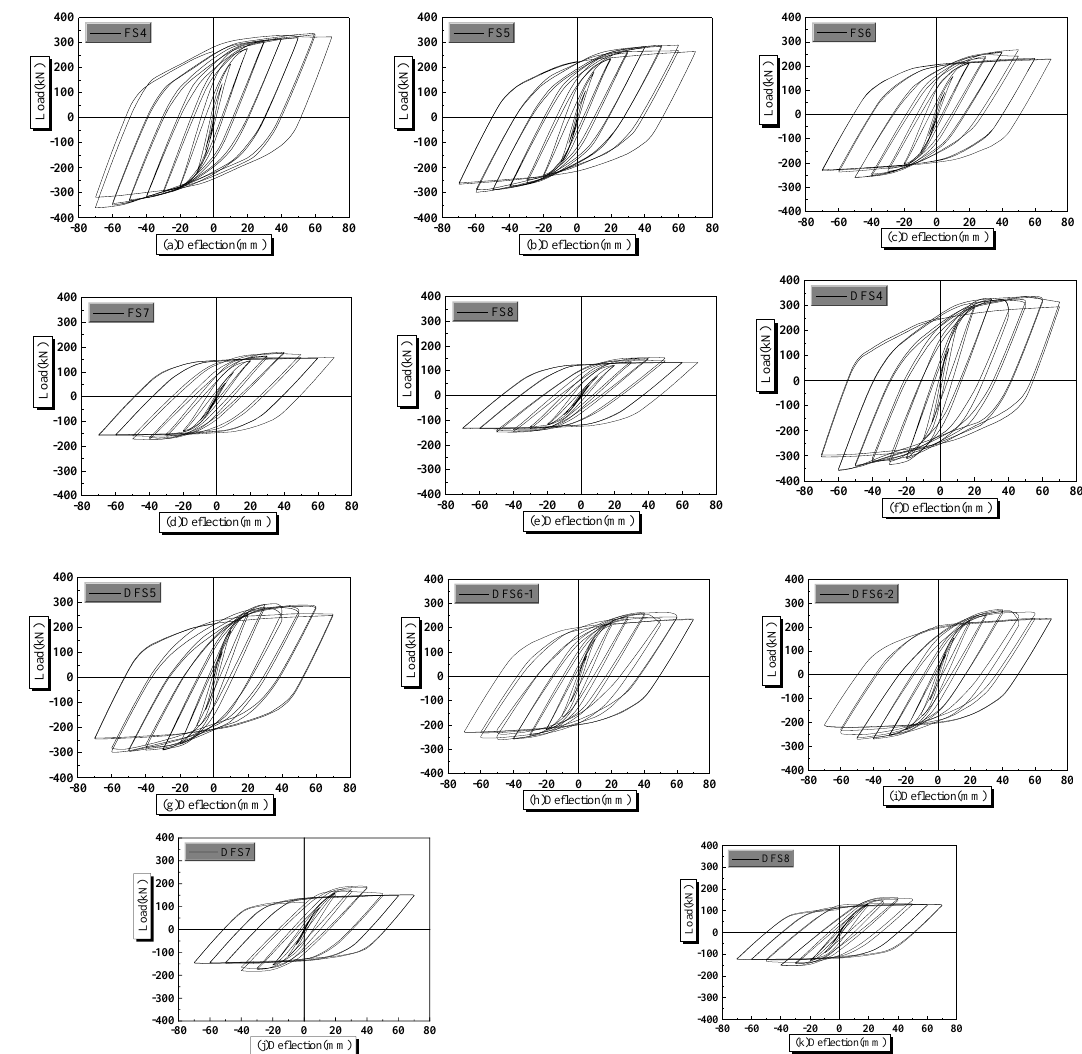
Figure 10. Hysteretic curves for PPSRC joints e: ( a ) model FS4; ( b ) model FS5; ( c ) model FS6; ( d ) model FS7; ( e ) model FS8; ( f ) model DFS4; ( g ) model DFS5; ( h ) model DFS6-1; ( i ) model DFS6-2; ( j ) model DFS7; ( k ) model DFS8.